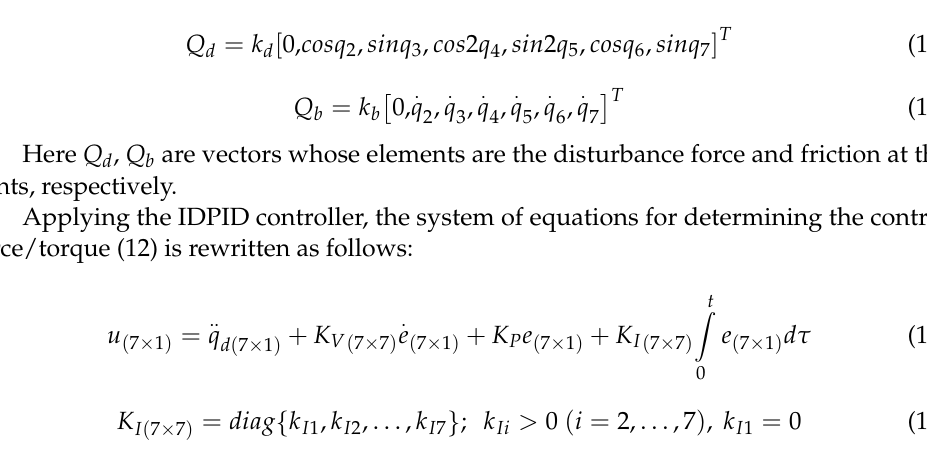
Figure 12. The general structure of a fuzzy controller of a bipedal robot. The problem of fuzzy logic-based controllers is that there is no common rule or method for constructing control rules, as well as no rule or method for fuzzification and defuzzification. The processes of fuzzification, defuzzification, and building fuzzy rules for the controller are based on expert knowledge and depend entirely on the designer. Fortunately, fuzzy rules can be built and integrated from very simple basic fuzzy rules, in simple natural languages. In the paper, the steps of fuzzification and building a fuzzy rule system, along with applying an inference method and defuzzification corresponding to the blocks in Figure 12, are presented below. 5.1. Fuzzification 5.1.1. The Input, Output Signals, and Physical Value Domains The input signals were the position error e ( t ) and velocity error e ( t ) of the joints gen- erated from comparing quantities that define the robot ’ s motion trajectory represented by the joint coordinates q d and their derivative d q , with response values of the corresponding quantities, q , q . These quantities were determined according to Equation (13). The output signal of the controller was the value of driving moments U ( t ) at the driven joints, which ensured the motion trajectory of the robot — i.e., with the errors e ( t ), e ( t ) as small as pos- sible, relative to the desired value — and ensures the relative equilibrium. The driving moments U ( t ) depended on the motion requirements of the robot as well as the geometrical, kinematical, and dynamical parameters of the robot. For crisp control- lers in general, and IDPD and IDPID controllers, the computation of these moments is based on a dynamical model, which is a system of differential equations of motion, and can have kinematic constraints by errors of position e ( t ) and velocity e ( t ). With the fuzzy controller applied in this paper, the calculation of U ( t ) did not use the dynamical model but only relied on a fuzzy rule system built based on expert knowledge and on the errors e ( t ), e ( t ). To accomplish that, one of the first requirements was to determine the physical value domain of the control moments U ( t ) as well as the physical value domain where the errors e ( t ) and e ( t ) could occur. Using the minimum and maximum limit values, the physical value domains of errors e ( t ), e ( t ), and driving torque U ( t ) are denoted as follows: